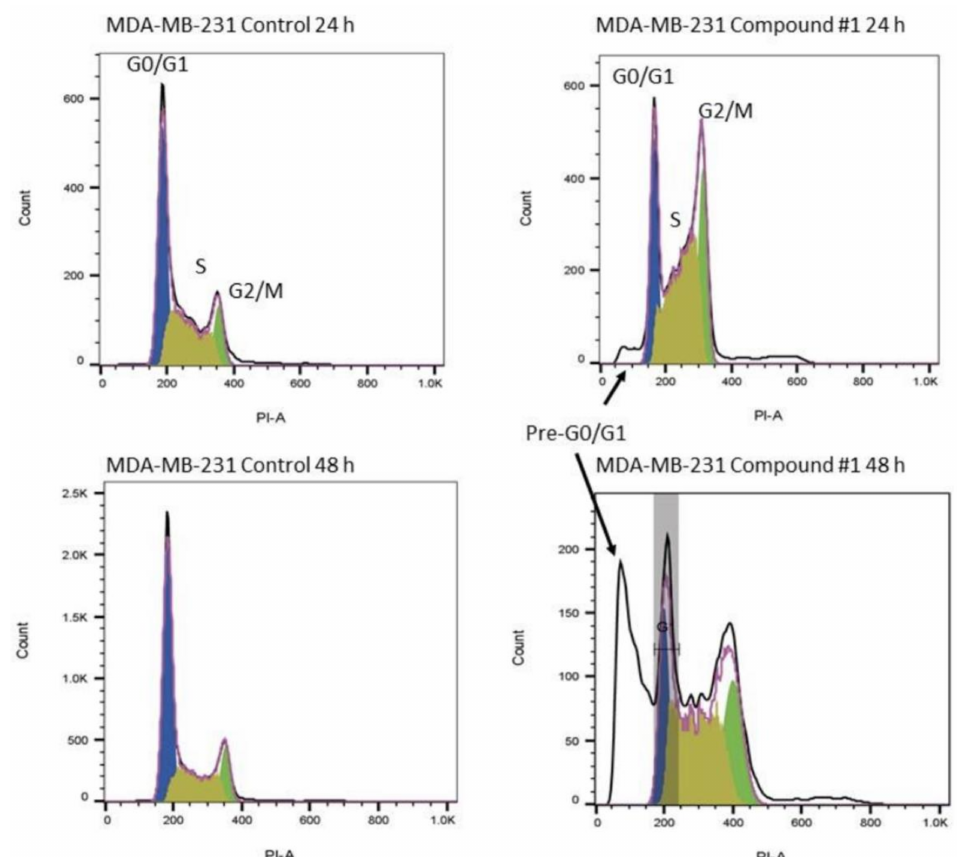
Figure 10. Histograms representing the cell cycle stages (pre-G0/G1, G0/G1, S, and G2/M) in MDA-MB-231 24 and 48 h in the presence of compound #1 ( right ) compared to the control ( left